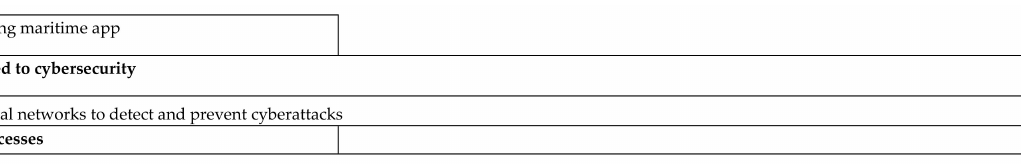
Figure A19. Cont